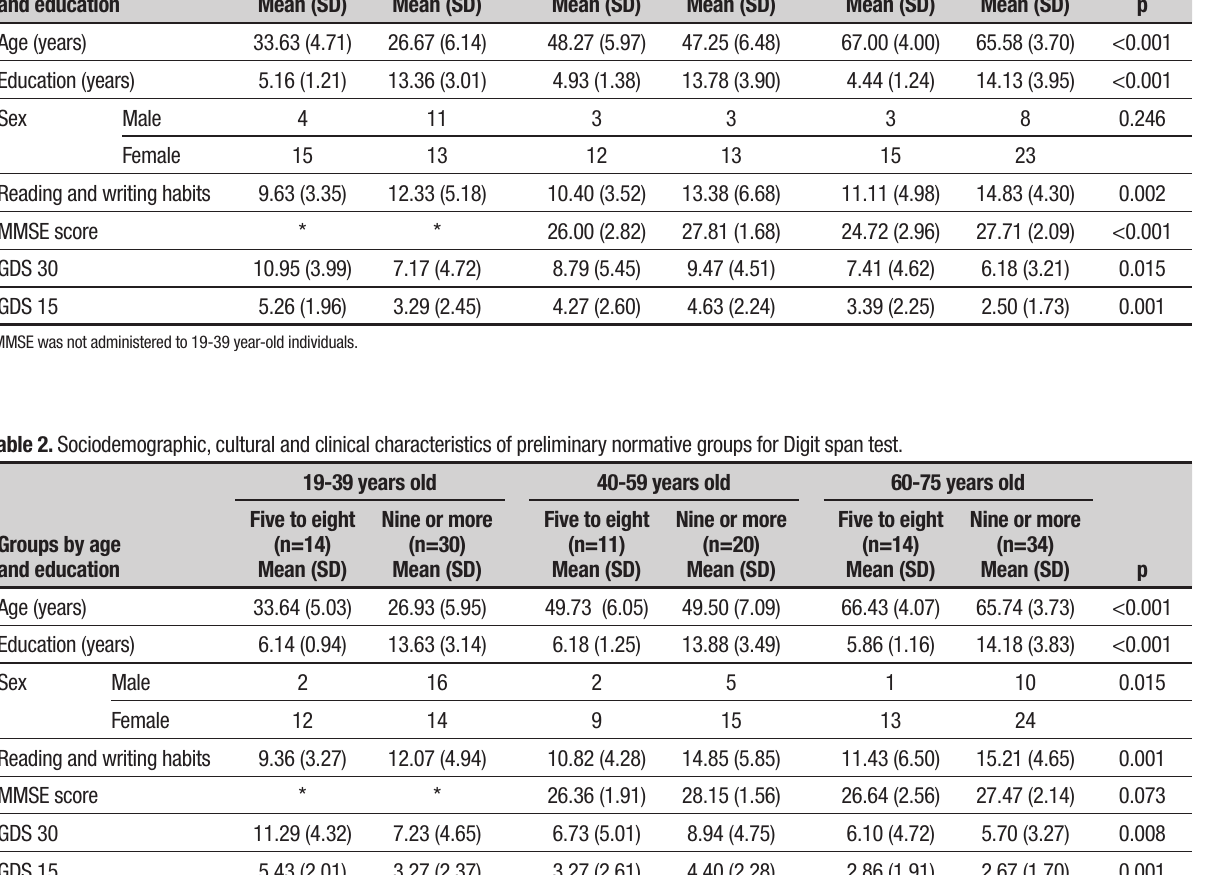
Groups by age and education